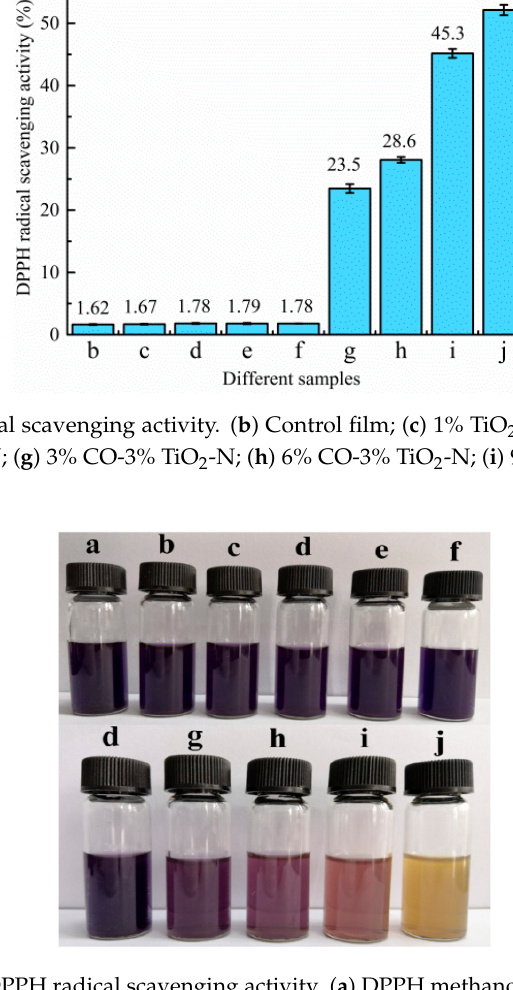
Figure 8. Pictures of DPPH radical scavenging activity. ( a ) DPPH methanol solution; ( b ) control film; ( c ) 1% TiO 2 -N; ( d ) 3% TiO 2 -N; ( e ) 5% TiO 2 -N; ( f ) 7% TiO 2 -N; ( g ) 3% CO-3% TiO 2 -N; ( h ) 6% CO-3% TiO 2 -N; ( i ) 9% CO-3% TiO 2 -N; and ( j ) 12% CO-3% TiO 2 -N.